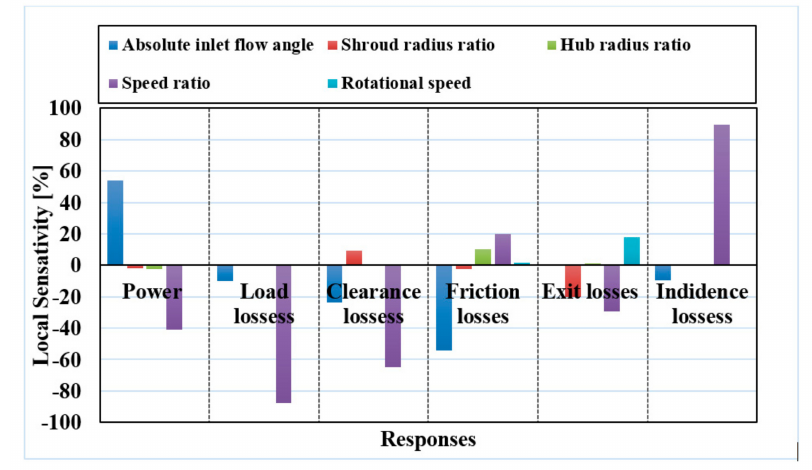
Figure 8. Sensitivity analysis of design